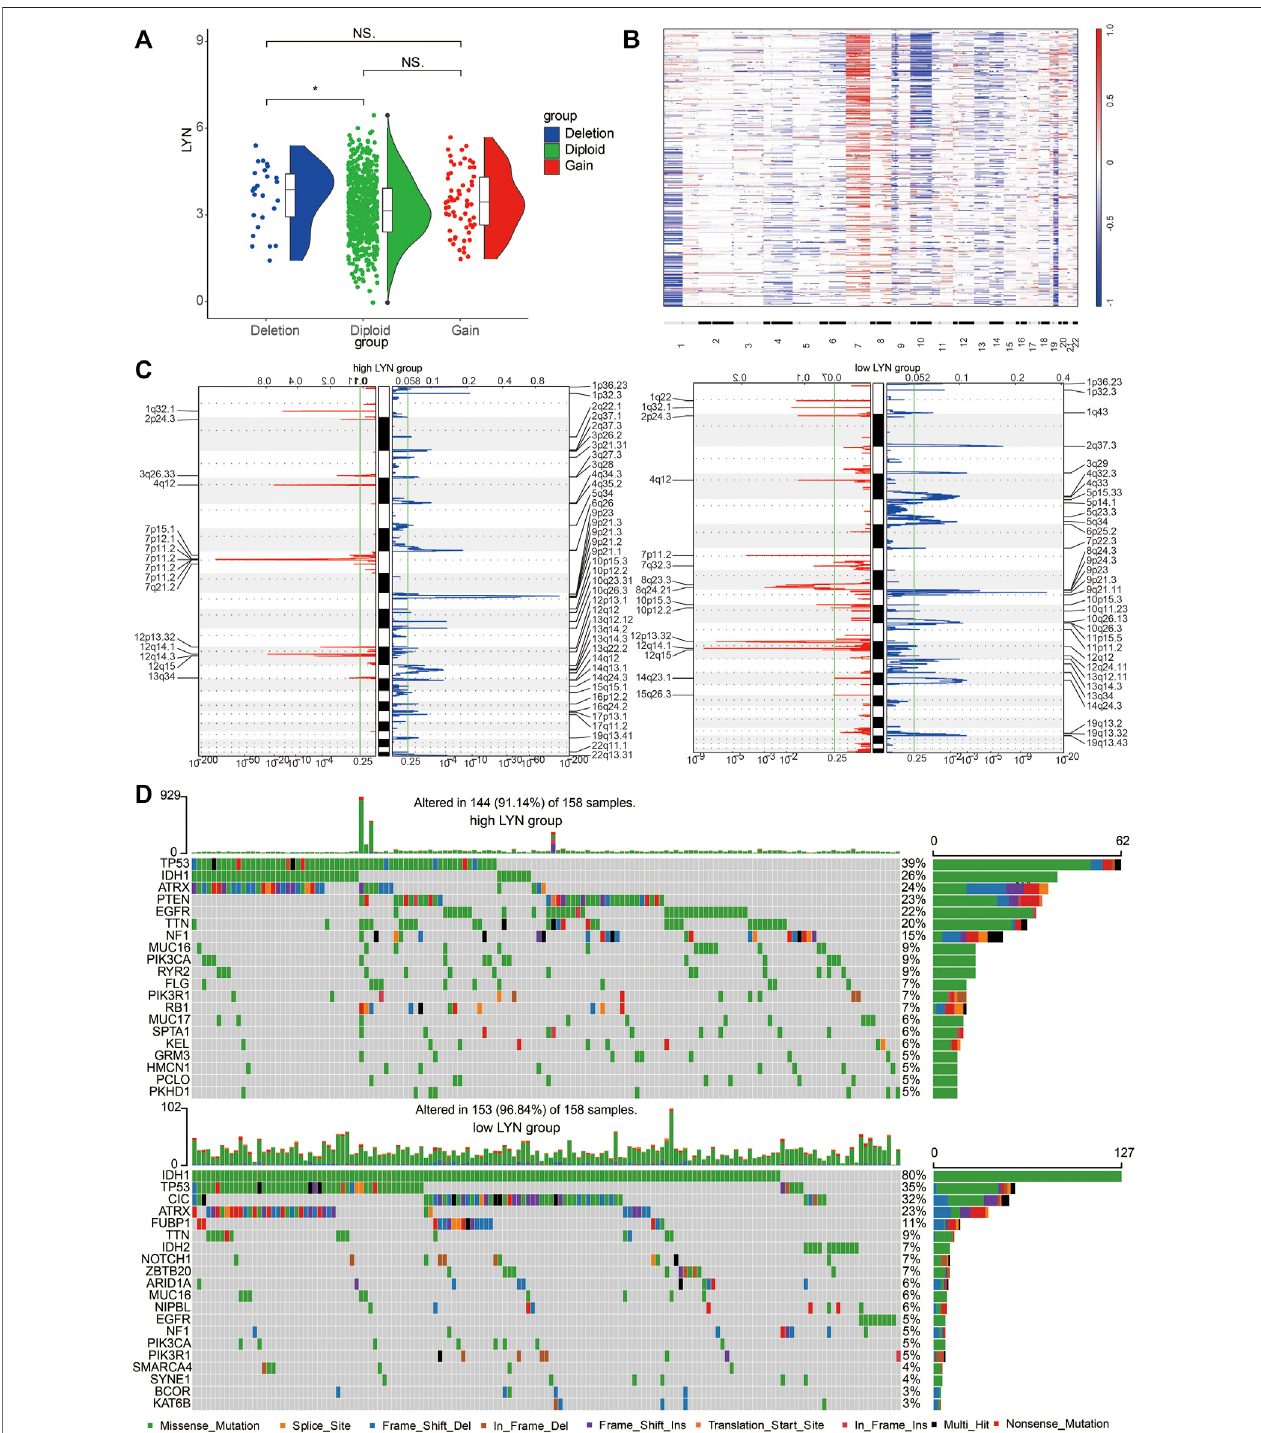
FIGURE 4 | Different genomic alterations are related to LYN expression (A) . Relationship between LYN expression and copy number variation in TCGA. NS, *, **, and ***indicate p < 0.05, p < 0.01, p < 0.001,andnosigni fi cantdifference,respectively (B) .TheoverallCNApro fi le based onLYNexpression. 22humanchromosomes are numbered 1 to 22 consecutively (C) . Genomic events in glioma samples with low and high LYN expression based on GISTIC 2.0. Chromosomal locations of ampli fi cation peaks (red) and deletions peaks (blue) are presented (D) . Different genomic alterations in glioma samples with low and high LYN expression.